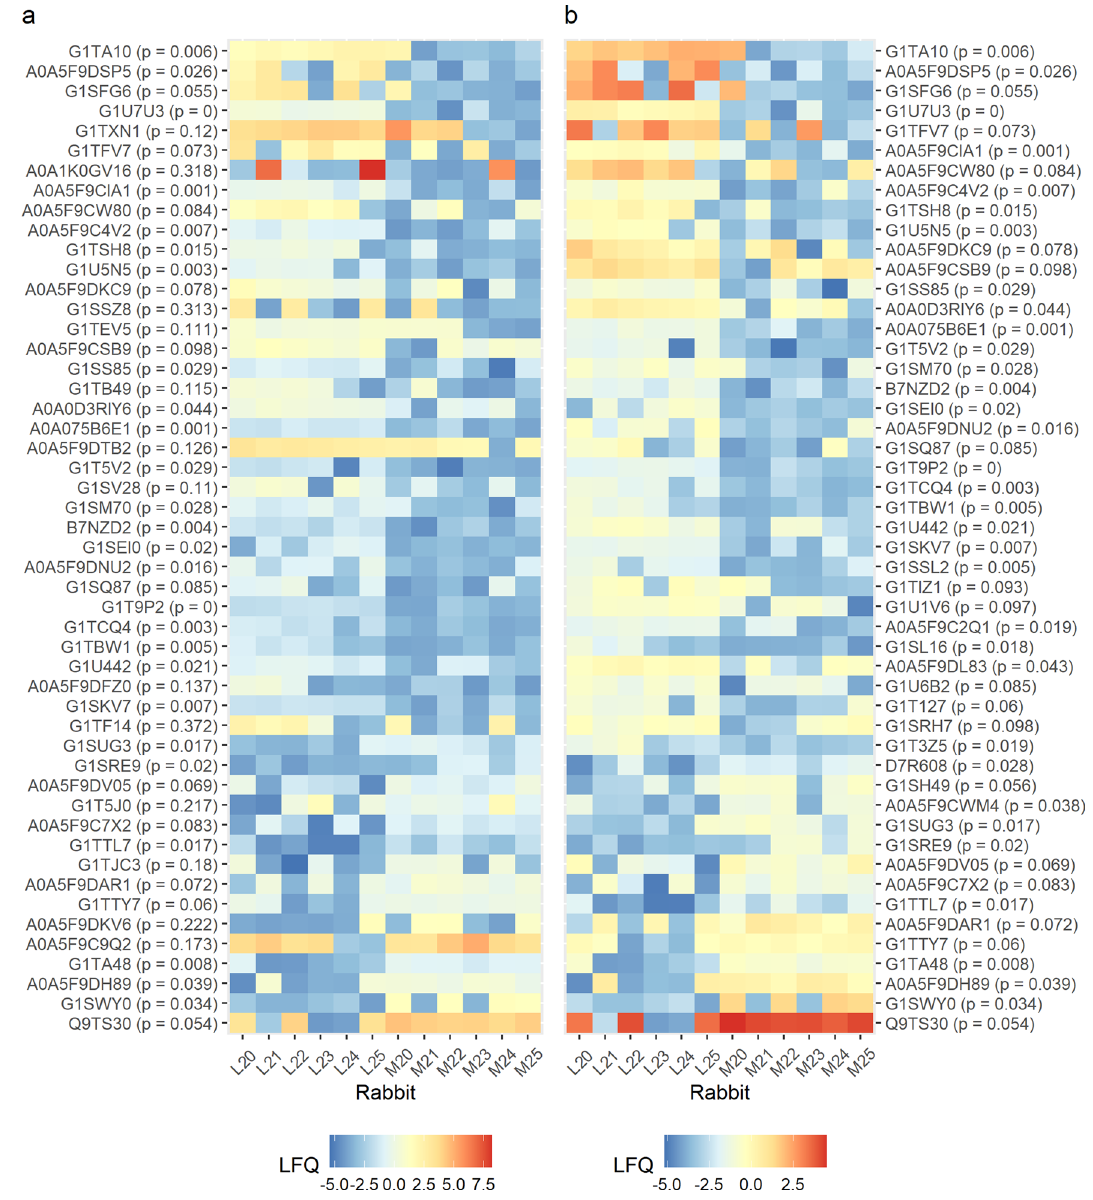
Figure 6. Heatmaps for differential protein expression in Analysis 2. ( a ) The top 50 proteins by absolute mean difference (log2 scale) from the full set of proteins (n = 1466). ( b ) The top 50 proteins by absolute mean difference (log2 scale) from the contracted set of proteins with p ≤ 0.1 (n = 234) were considered for gene enrichment principal component analysis. C20–25 indicate the control rabbits exposed to moderate humidity, and L20–25 the rabbits exposed to low